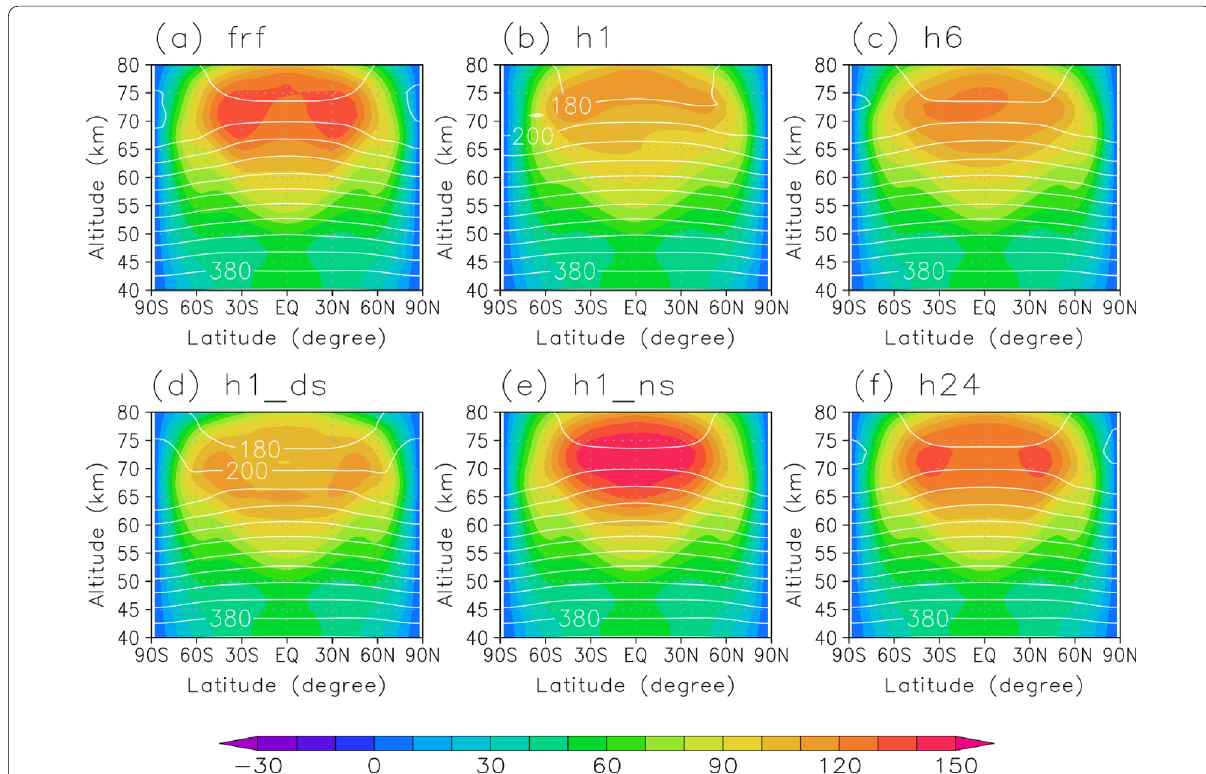
Fig. 4 Zonal–mean zonal wind (colors, m s − 1 ) and temperature (white contours, K) in a latitude–height cross section at the final day. The cases of a frf, b h1, c h6, d h1_ds, e h1_ns, and f h24 are